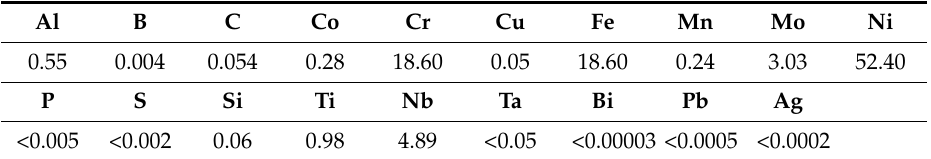
Table 4. Inconel 718 composition (wt %) (Haynes ® 718 alloy) [36].